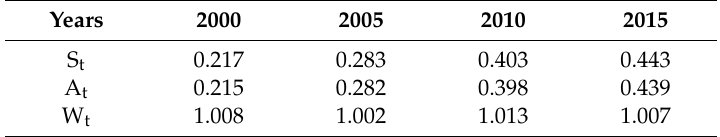
Table 3. Socio-economic correction coe ffi cient of Shangzhou district from 2000 to